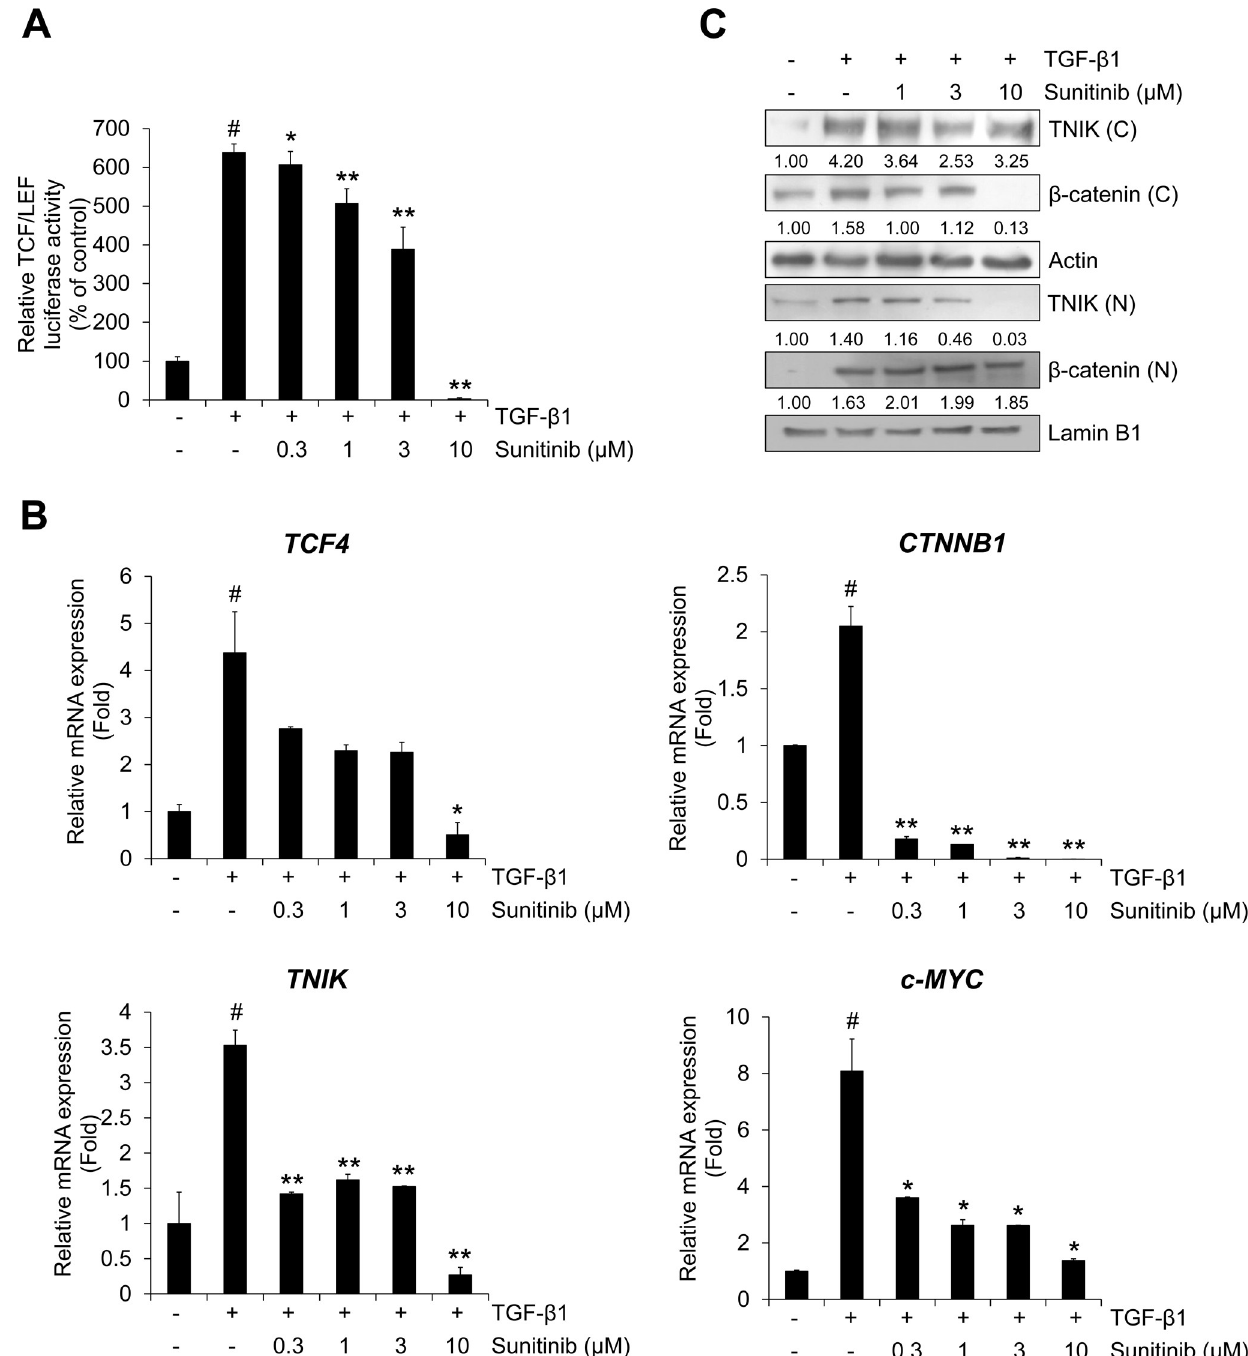
Fig 3. Sunitinib inhibits TGF- β 1-induced Wnt signaling. (A) Effect of sunitinib on TCF4 transcriptional activity. A549 cells were treated with TGF- β 1 (5 ng/mL) or its combination with sunitinib for 48 h before measuring TOPflash luciferase activity. FOPflash-normalized TOPflash luciferase activity is represented as the relative TCF/LEF luciferase activity. (B) A549 cells were pretreated with sunitinib for 3 h, and then incubated with TGF- β 1 (5 ng/mL) for 1 h. After RNA extraction and cDNA synthesis, the mRNA expression of TNIK and Wnt target genes was measured by qRT-PCR. (C) The protein levels of TNIK and β -catenin in cytosolic and nuclear fractions were measured by Western blot. Actin and lamin B1 were used as loading controls for the cytosolic and nuclear fractions, respectively. The results are representative of triplicate experiments. # p < 0.01 versus control; � p < 0.05, �� p < 0.01 versus treatment with TGF- β 1